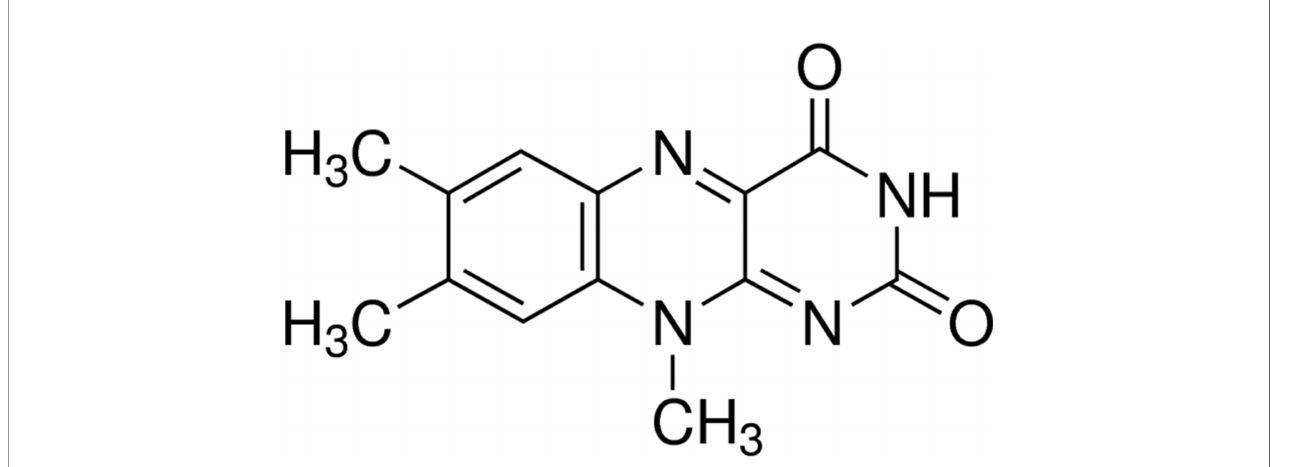
FIGURE 1 | Chemical structure of lumi fl